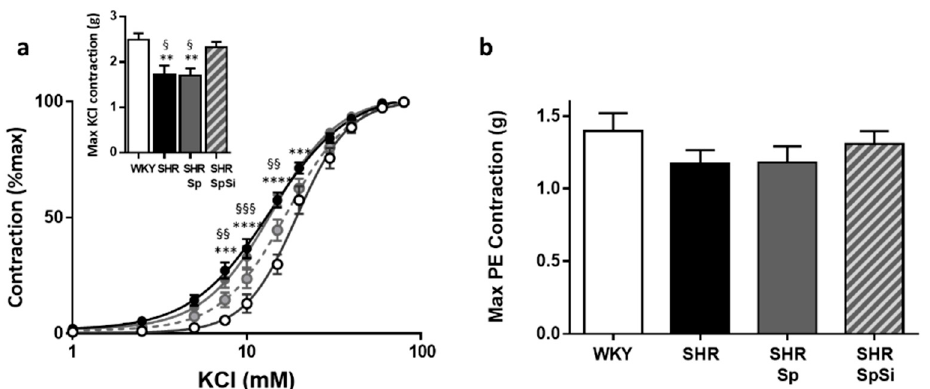
Figure 4. E ff ect of supplementation on contractile response of aorta. ( a ) Curves summarize cumulative dose-responses to KCl in aortic rings from WKY (white symbol), SHR (black symbol), SHR-Sp (grey symbol) and SHR-SpSi (dotted grey symbol). The inset shows the maximal KCl-induced contraction expressed in grams. ( b ) Bar graph presents the maximal contractions induced by PE in all experimental groups. Data represent mean ± s.e.m ( n = 15 in each group). **** p < 0.0001, *** p < 0.001, ** p < 0.01 vs. WKY; §§§ p < 0.001, §§ p < 0.01, § p < 0.05 vs. SHR-SpSi. Table 2. Maximal responses (E max ) and sensitivity (EC 50 ) for the various agonists and antagonists of the contractile response on rat aorta. KCl PE L-NAME / PE Ach SNP